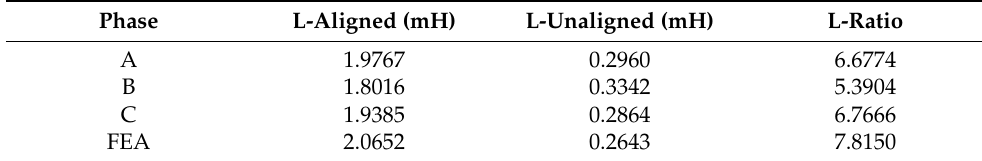
Table 6. Measured inductance value compared to